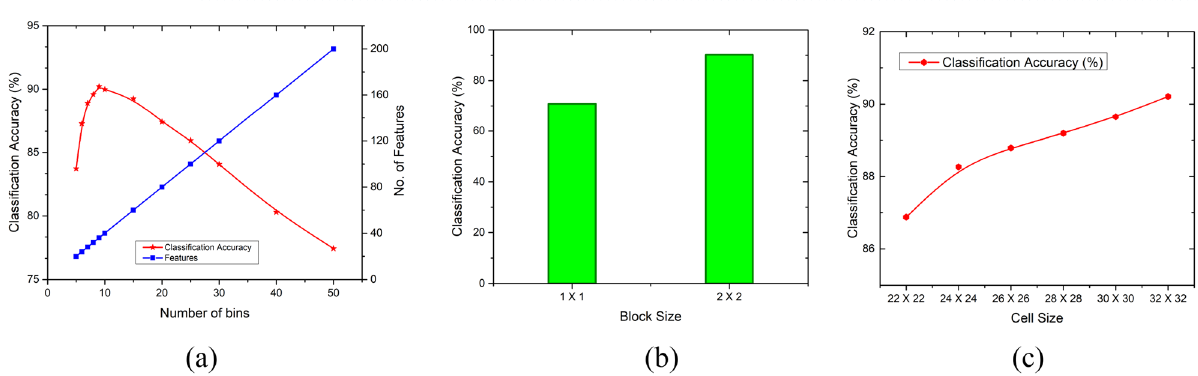
Figure 12. The variation of classification performance accuracy using GLCM feature descriptor for different values of d with variation in θ as 0°, 45°, 90°, and 135°, ( a ) Offset matrix, and ( b ) accuracy versus d plot.